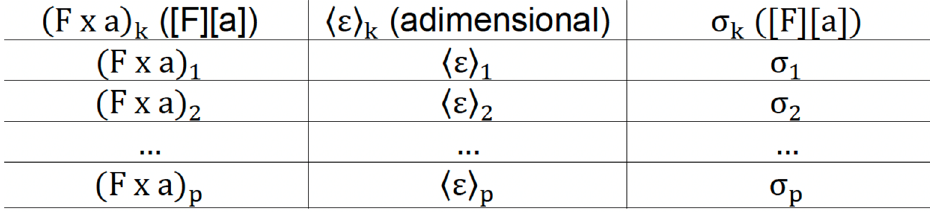
Figure 17. Linear regression graph of force factor by relative strain. Regarding the determination of the transfer of uncertainty from the independent var- iable to the dependent variable, it was done through the assumption of the adjustment function as linear. Thus, the combined uncertainties, from the uncertainties of the depend- ent and independent variables, using expression (8.1); then it is necessary to tabulate the values of force*factor(a), relative mean strains, and combined uncertainties; consecutively it is necessary to include the experimental values and their combined uncertainties in the graph of force*factor(a) by average strain; finally, performing the linear regression to de- termine the best line that represents the chosen linear function, expression (8) (Figure 15). Torres (2005) [73] indicates that the PA model replicates the formation of bands or fringes that can be light or dark, proportionally to the differences in the main stresses that exist in the observed model. The PA technique transforms these stresses present inside the body into visible light patterns. The higher the quanta of the fringe or band, the higher the stress concentration [73–75]. Some studies presented in Torres (2005) [73] highlight the illustrative capacity that photoelastic analysis has in the fields of stress localization and characterization [74–76]. This analysis is being successfully used in research on interactions in tissue responses and phys- ical characteristics of prosthetic restorations and implants [76]. Studies with PA verified the